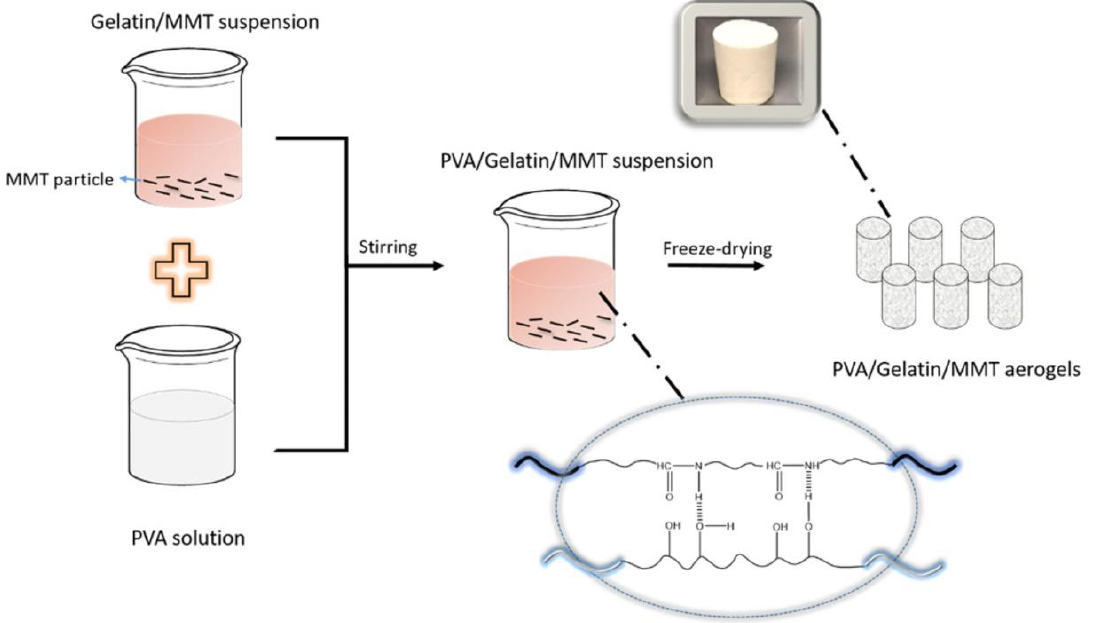
Figure 3. Blending approach to synthesize composite hydrogel. Reproduced with the permission of [49] , Copyright 2017 American Chemical Society. of [49], Copyright 2017 American Chemical